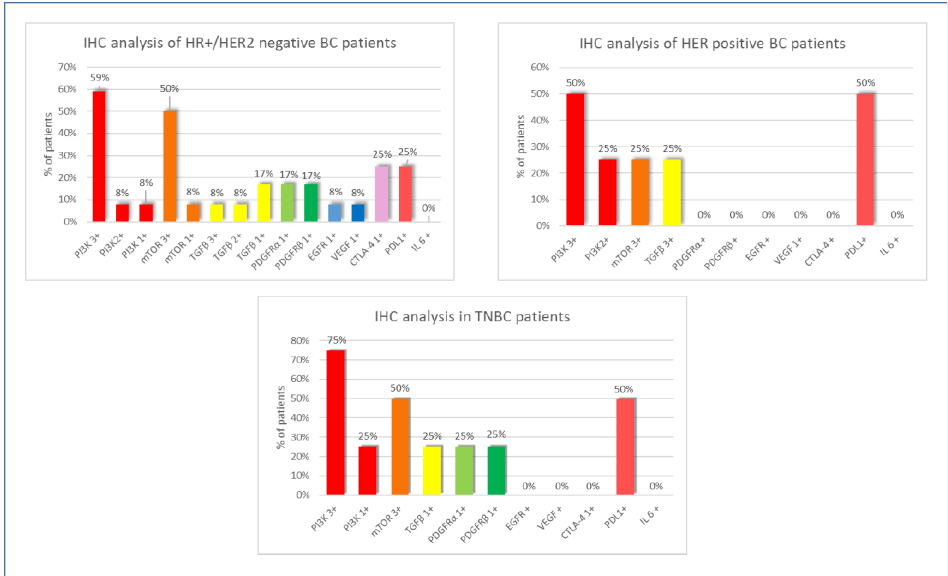
Figure 3. Immunohistochemical analysis of Hormone positive/HER2 negative BC patients, HER2 positive BC patients and Triple Negative BC patients. Table 2. Significant correlations between main SSc features and some BC immunoistochemical